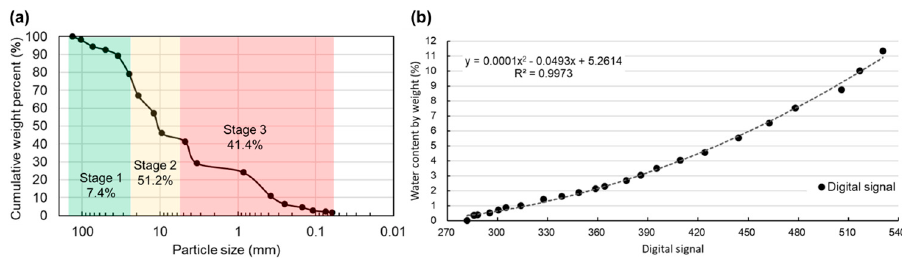
Figure 8. ( a ) Results of on-site soil sieving analysis. ( b ) Relationship between digital signal and weight-based soil moisture content graph.